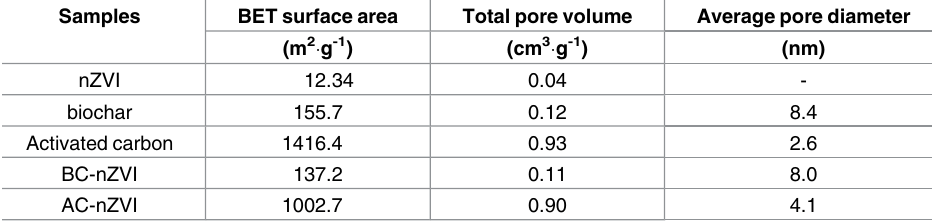
Table 1. BET surface areasand pore volumes of the nZVI, biochar, activated carbon, BC-nZVI, and AC-nZVI.